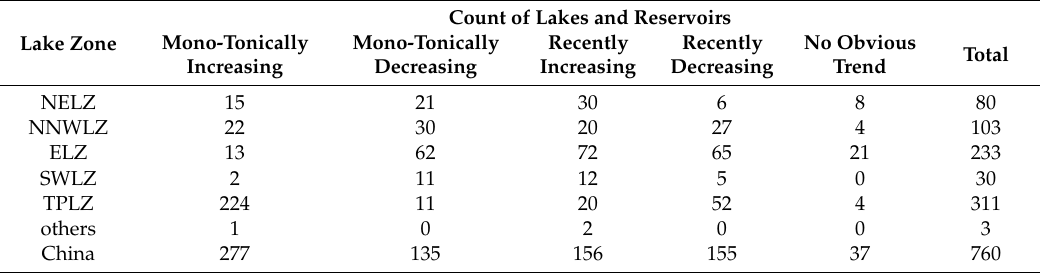
Table 2. Count of lakes and reservoirs based on the trend types of water storage change for the different lake zones and whole mainland China.